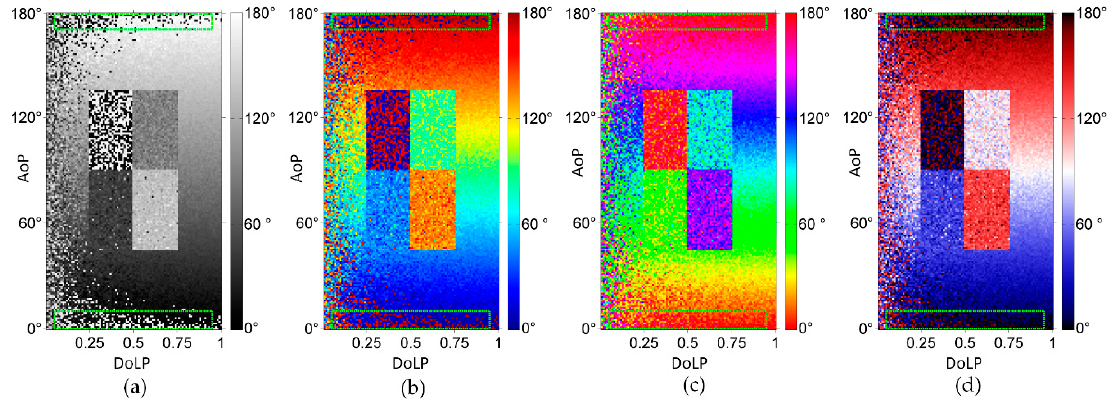
Figure 4. The numerical simulation results for different method. ( a ) AoP image by previous method 1; ( b ) AoP image by previous method 2; ( c ) AoP image by previous method 3; ( d ) AoP image by our method.